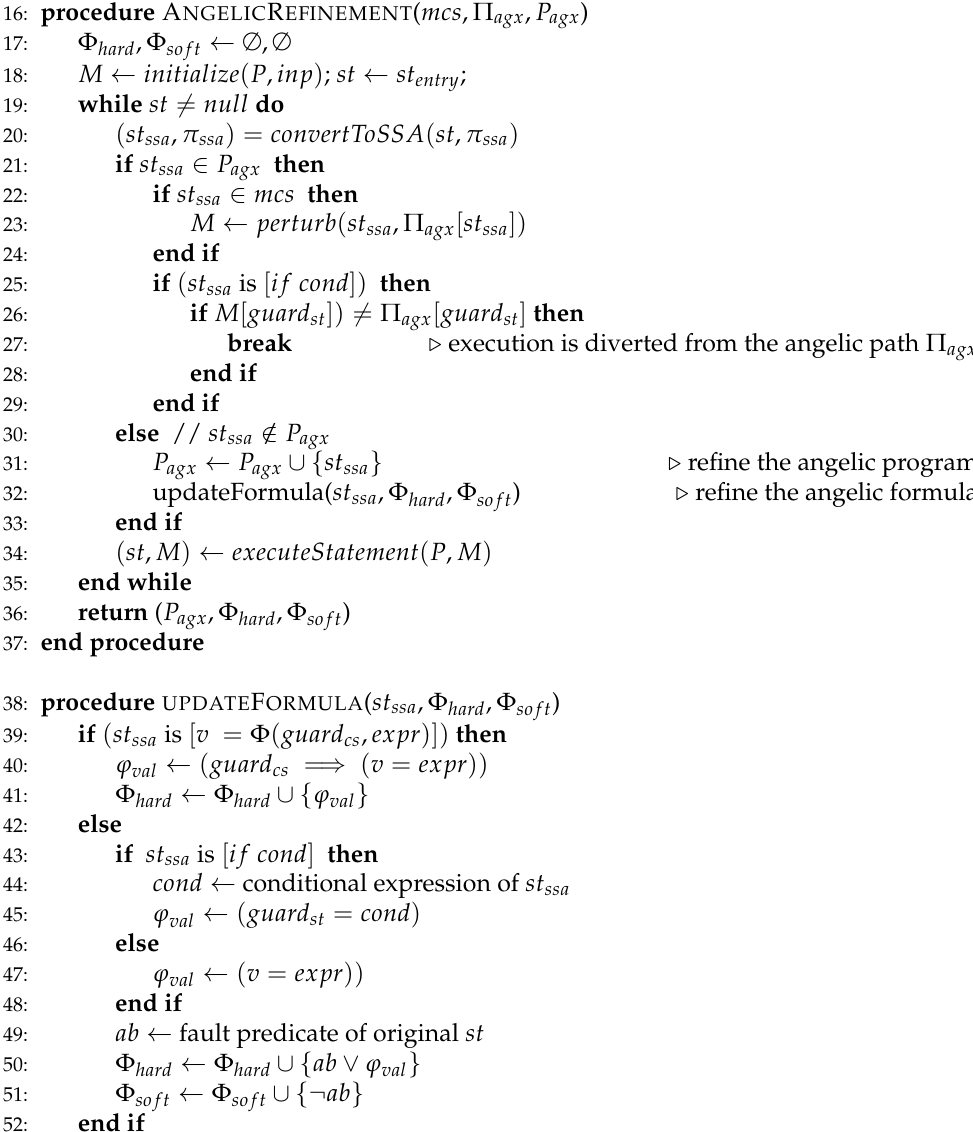
Algorithm 2 On-demand Program Explorer and Formula